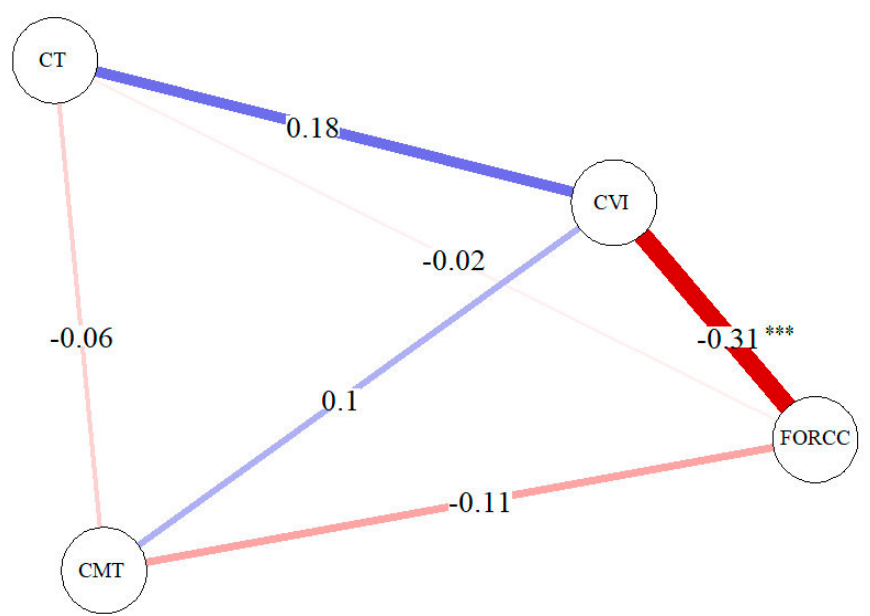
Figure 3. Correlation network analysis for MNV (all types). A blue line shows a positive correlation and a red line shows s negative correlation. The strength of the relation is shown by the thickness of the line. Significance code: *** p -value < 0.001.